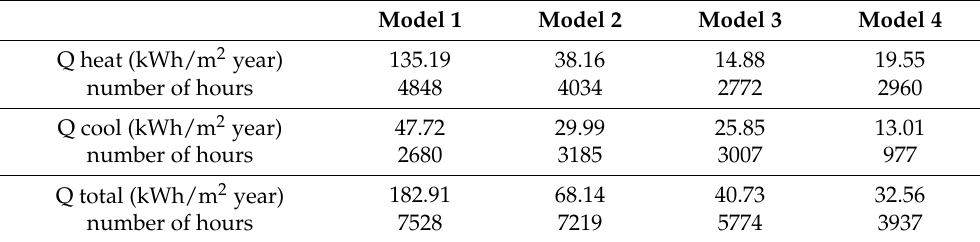
Table 3. Energy demand and number of hours during a